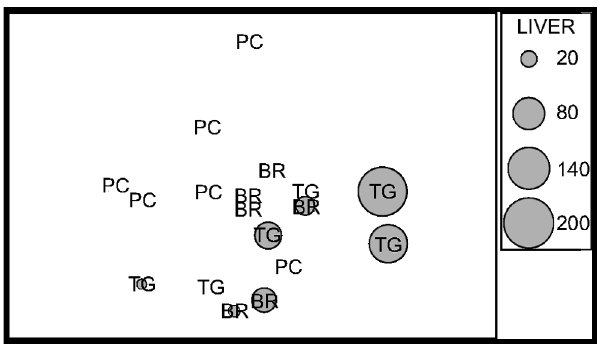
Figure 3. nMDS ordination of the Euclidean distance measure from normalized biomarker data. A subset of 18 individuals 6 15 biomarker responses was used. On each individual, grey circles of increasing size with increasing caulerpin concentration in liver were